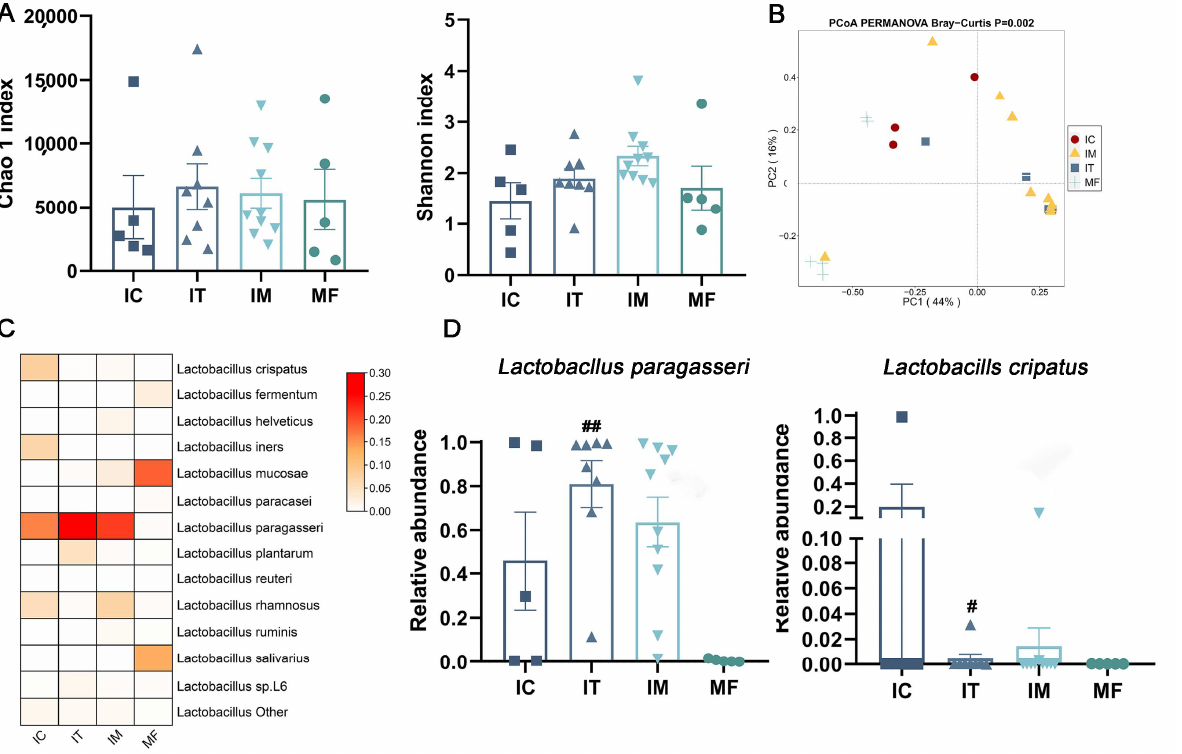
Figure 8. Diversity and composition of Lactobacillus in infant and maternal feces. ( A ) Alpha diversity and ( B ) beta diversity. PERMANOVA was used to calculate difference among samples based on Bray–Curtis distance. ( C ) Relative abundance of Lactobacillus was calculated with log10. Darker color corresponds to the genus of higher relative abundance. ( D ) Significant differences within Lactobacillus species across different samples. #, p < 0.05, ##, p < 0.01; three stages of infant feces compared to maternal feces. IC, IT, and IM stand for infant feces corresponding to colostrum, transitional milk, and mature milk. MF stands for maternal feces.